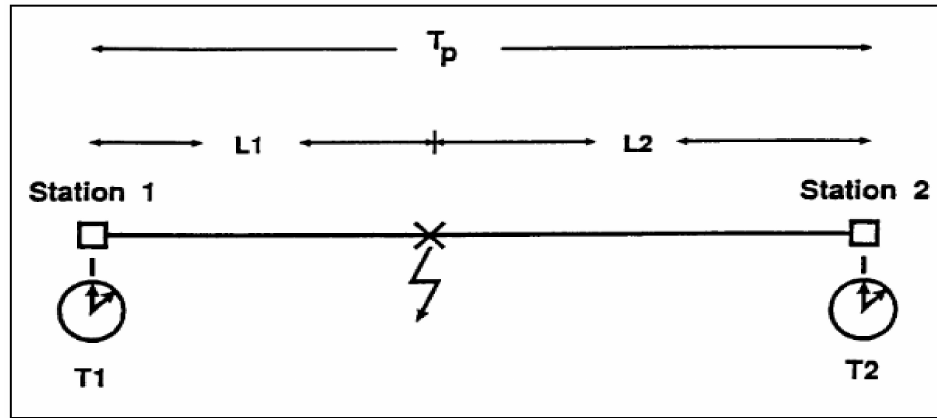
Figure 8. Travelling wave scheme in a transmission network